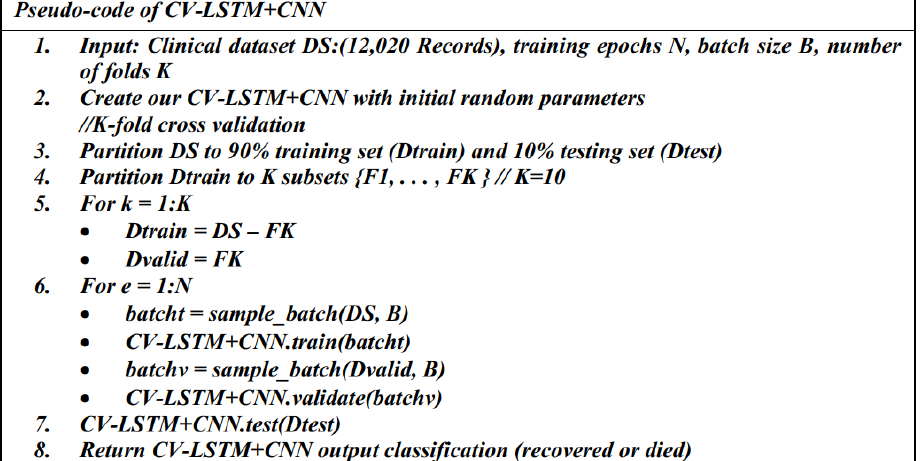
Figure 7. A schematic diagram of the CV-LSTM + CNN model.